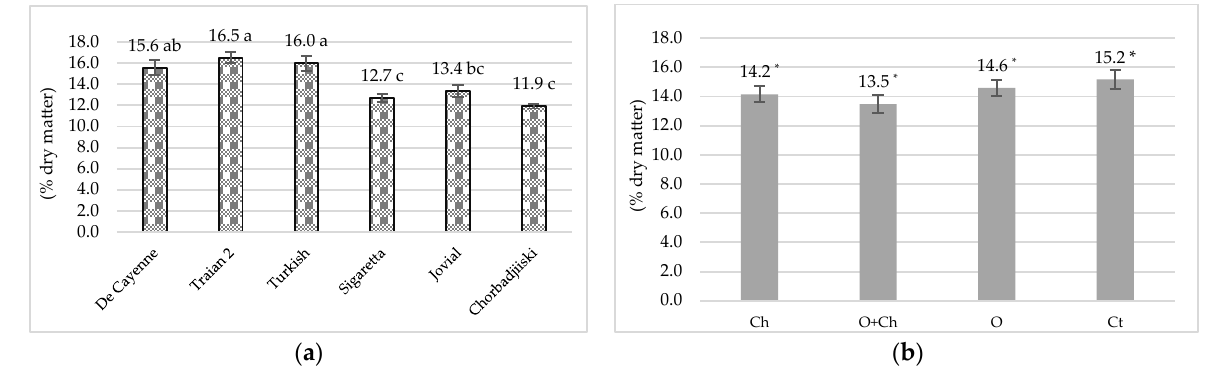
Figure 2. Dry matter content of samples influenced by cultivar ( a ) and fertilization ( b ). Ch—Chemical; O + Ch—Organic + Chemical; O—Organic; Ct—Control. Along each line, values followed by different letters are significantly different according to the Tukey’s test at p ≤ 0.05; *—non-significant.